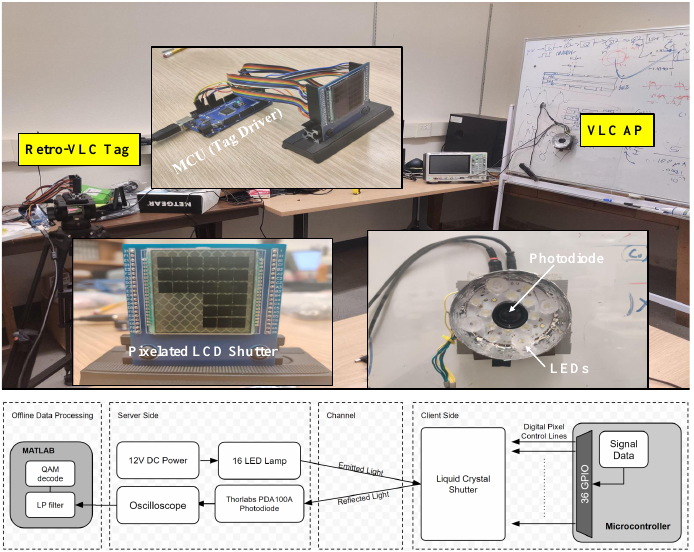
Figure 5. Testbed setup of Retro-VLC